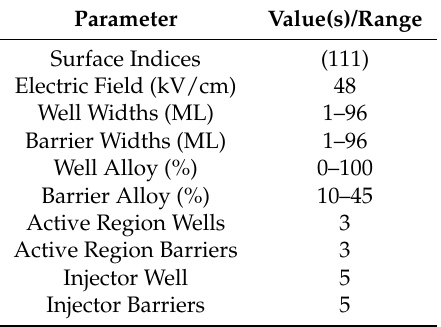
Table 2. Application specific simulation parameters for the